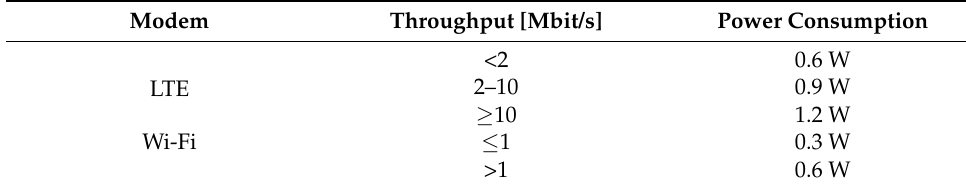
Table 3. Power consumption classes according to the measured network throughput. Modem Throughput